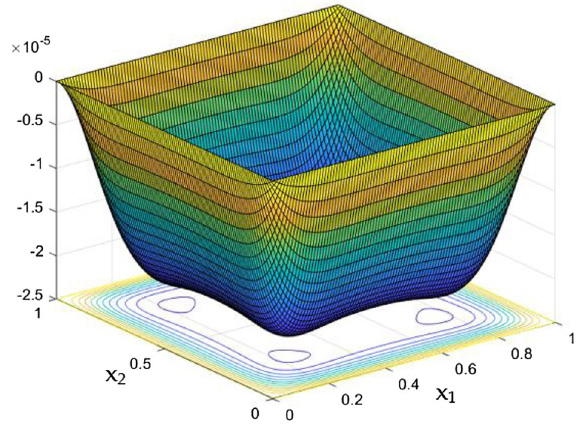
Figure 10. Temperature field for Ra = 50,000 in the absence of external MF.